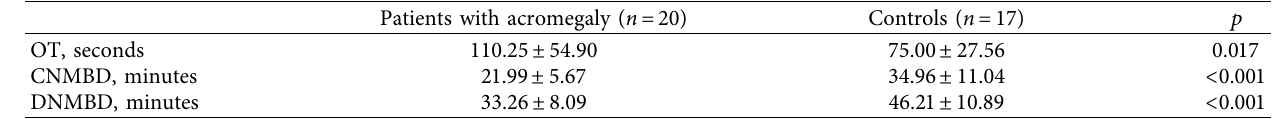
Table 2: Muscle relaxation parameters in patients with acromegaly and